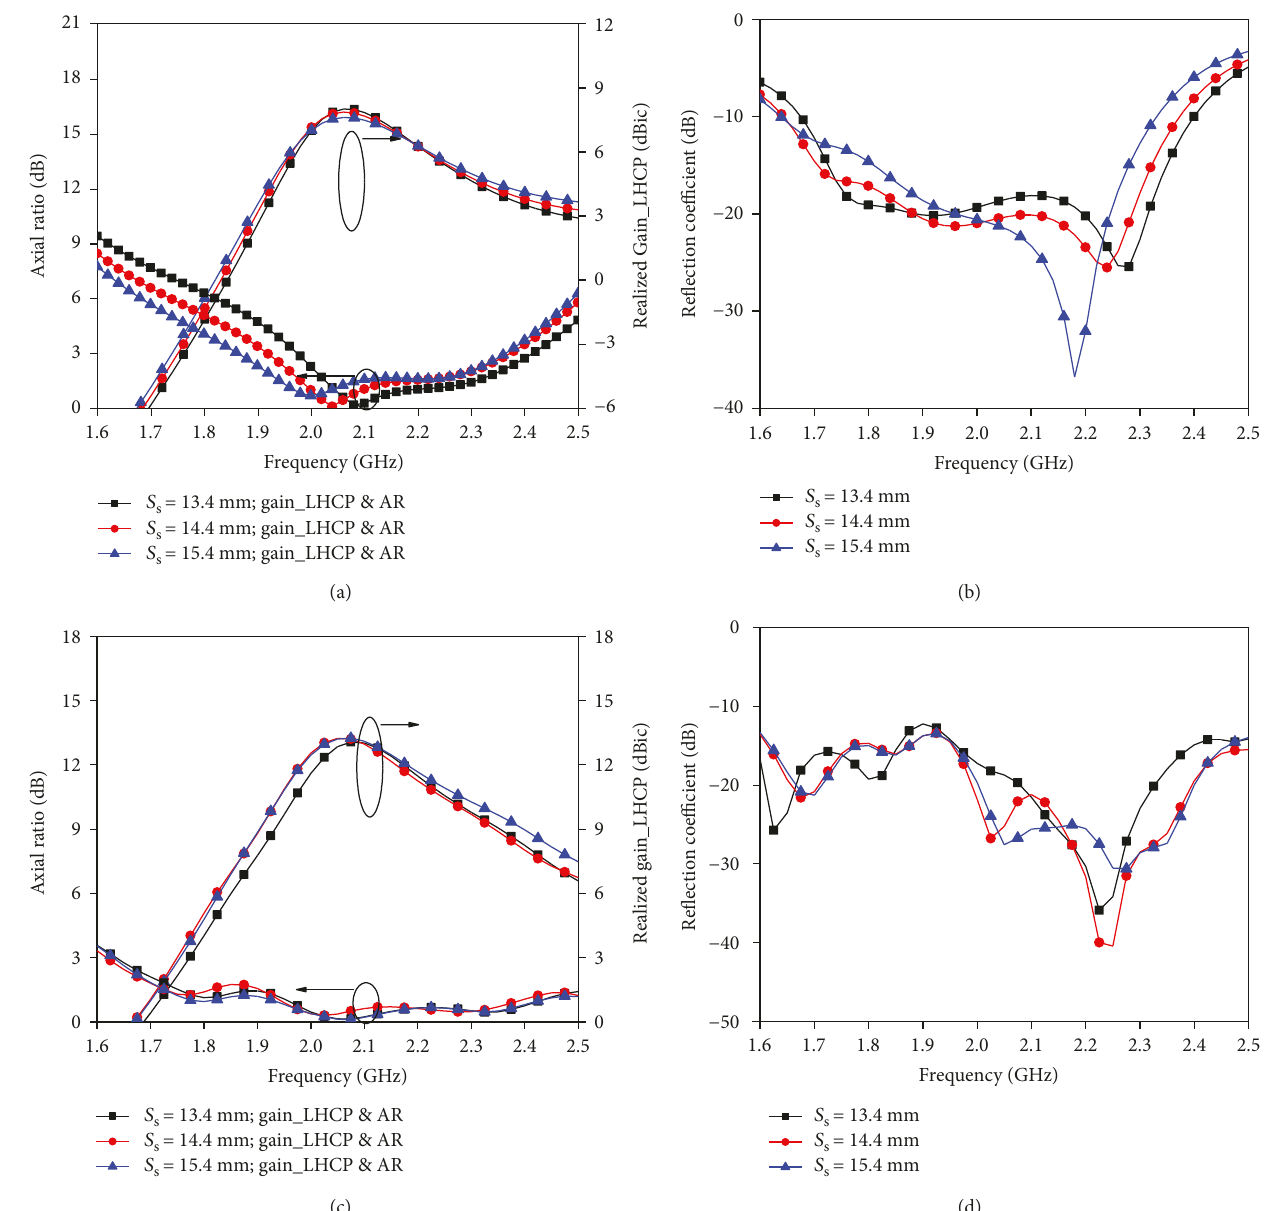
Figure 6: E ff ects of the length of the U-slot ’ s vertical arm. (a) Realized gain and axial ratio of the element. (b) Re fl ection coe ffi cient of the element. (c) Realized gain and axial ratio of the array. (d) Re fl ection coe ffi cient of the